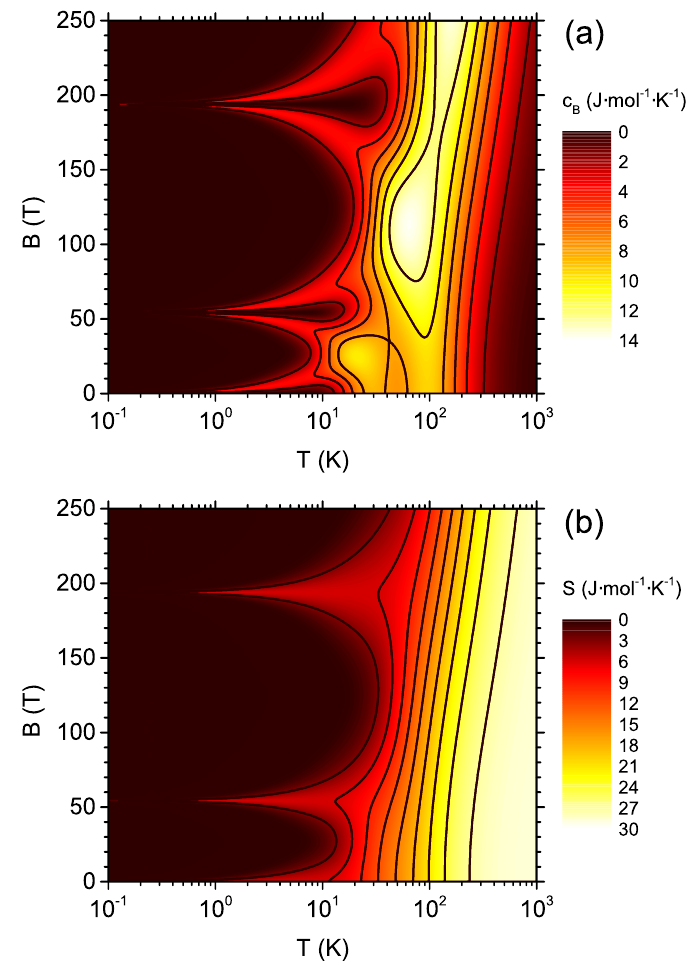
Figure 3. ( a ) The magnetic specific heat; and ( b ) the magnetic entropy as a function of the temperature and the external magnetic field. The features are visible in the vicinity of the quantum level crossings— for detailed discussion and critical field values, see Appendix